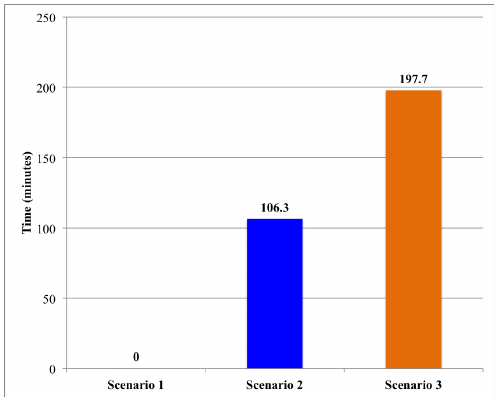
Figure 15. Training time of the three scenarios.